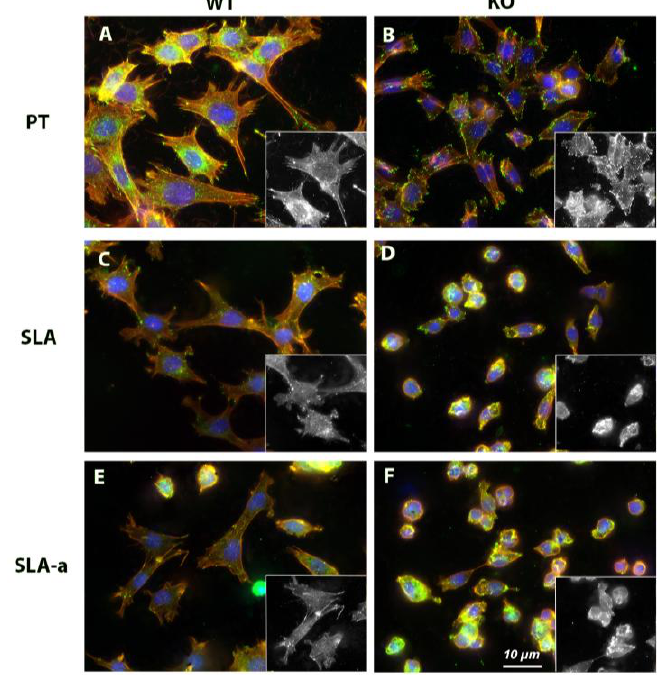
Figure 5. Influence of substratum topography and hydrophilicity on cortactin localization in FAK −/− and WT fibroblasts. FAK −/− and WT fibroblasts were cultured on PT, SLA (not shown) and hydrophilic SLA for 24 h and labeled with antibodies to cortactin (green), rhodamine-phalloidin for F-actin (red) and DAPI to visualize the nucleus